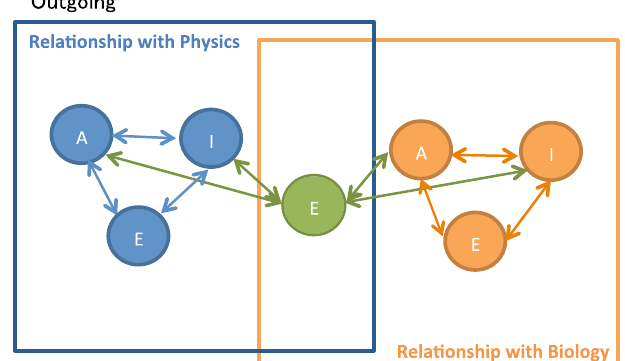
FIG. 9. Violet ’ s outgoing relationships with physics and with biology. In this representation the overlapped orange and blue boxes indicate the relationships beginning to overlap. This is connected with the green epistemology bubble in the overlap, indicating an epistemological stance that physics and biology knowledge are related. Within each relationship box the affect, identity, and epistemology bubbles are